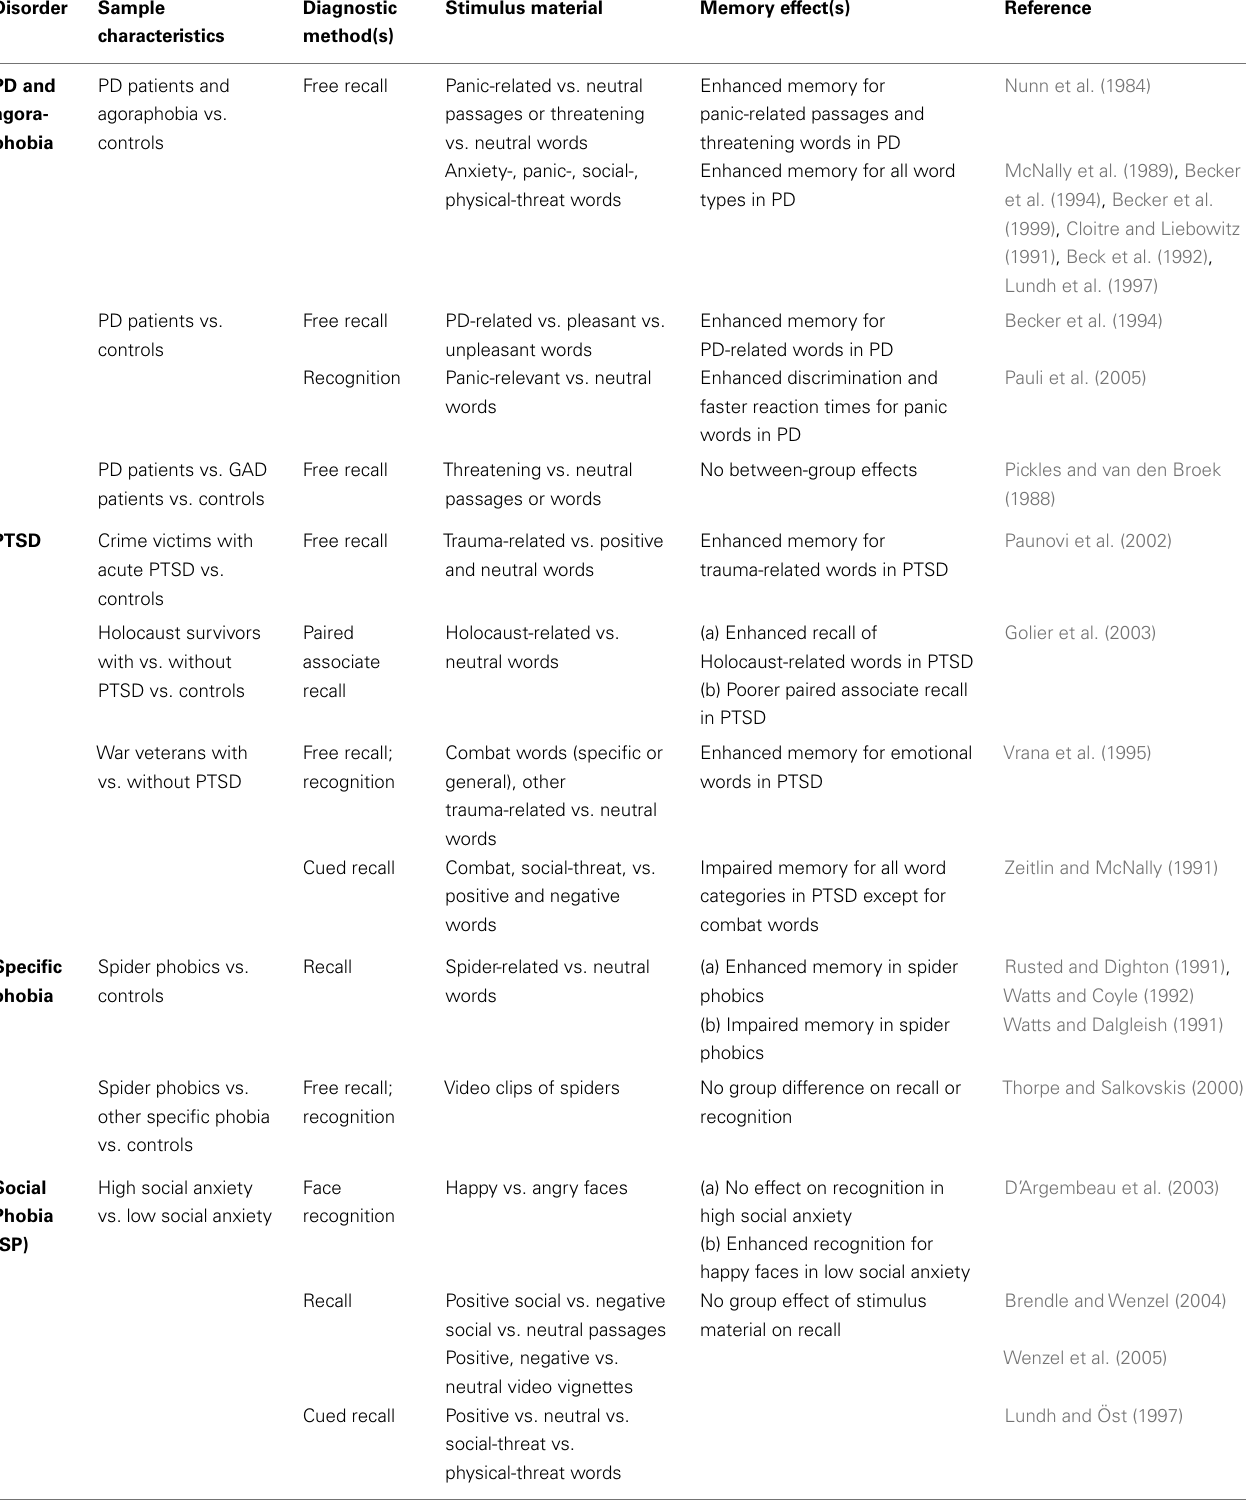
Table 1 | Diagnostic methods and findings from studies assessing episodic memory for emotional and/or disorder-related material in differentAD